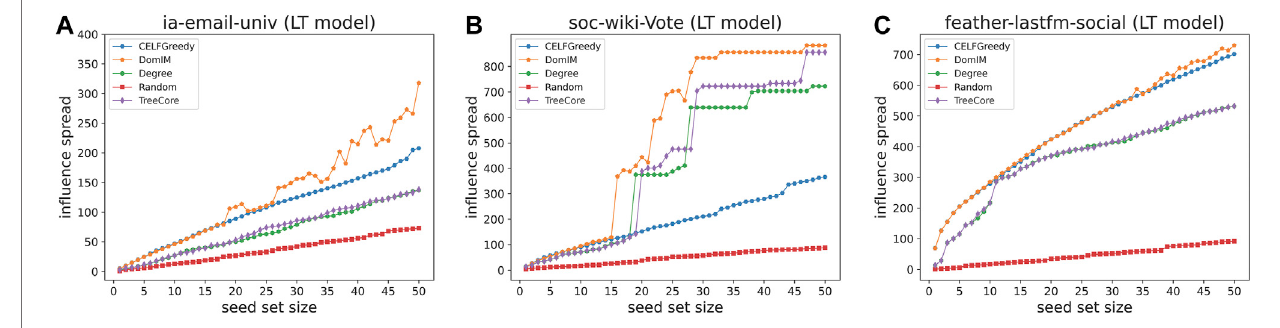
FIGURE 1 | Results of in fl uence spread under LT